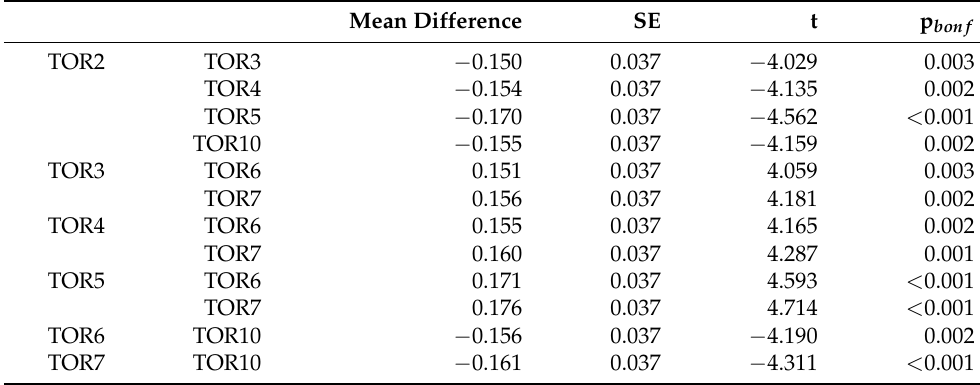
Table A1. Bonferroni post-hoc comparisons on vehicle jerk–main effect of time.